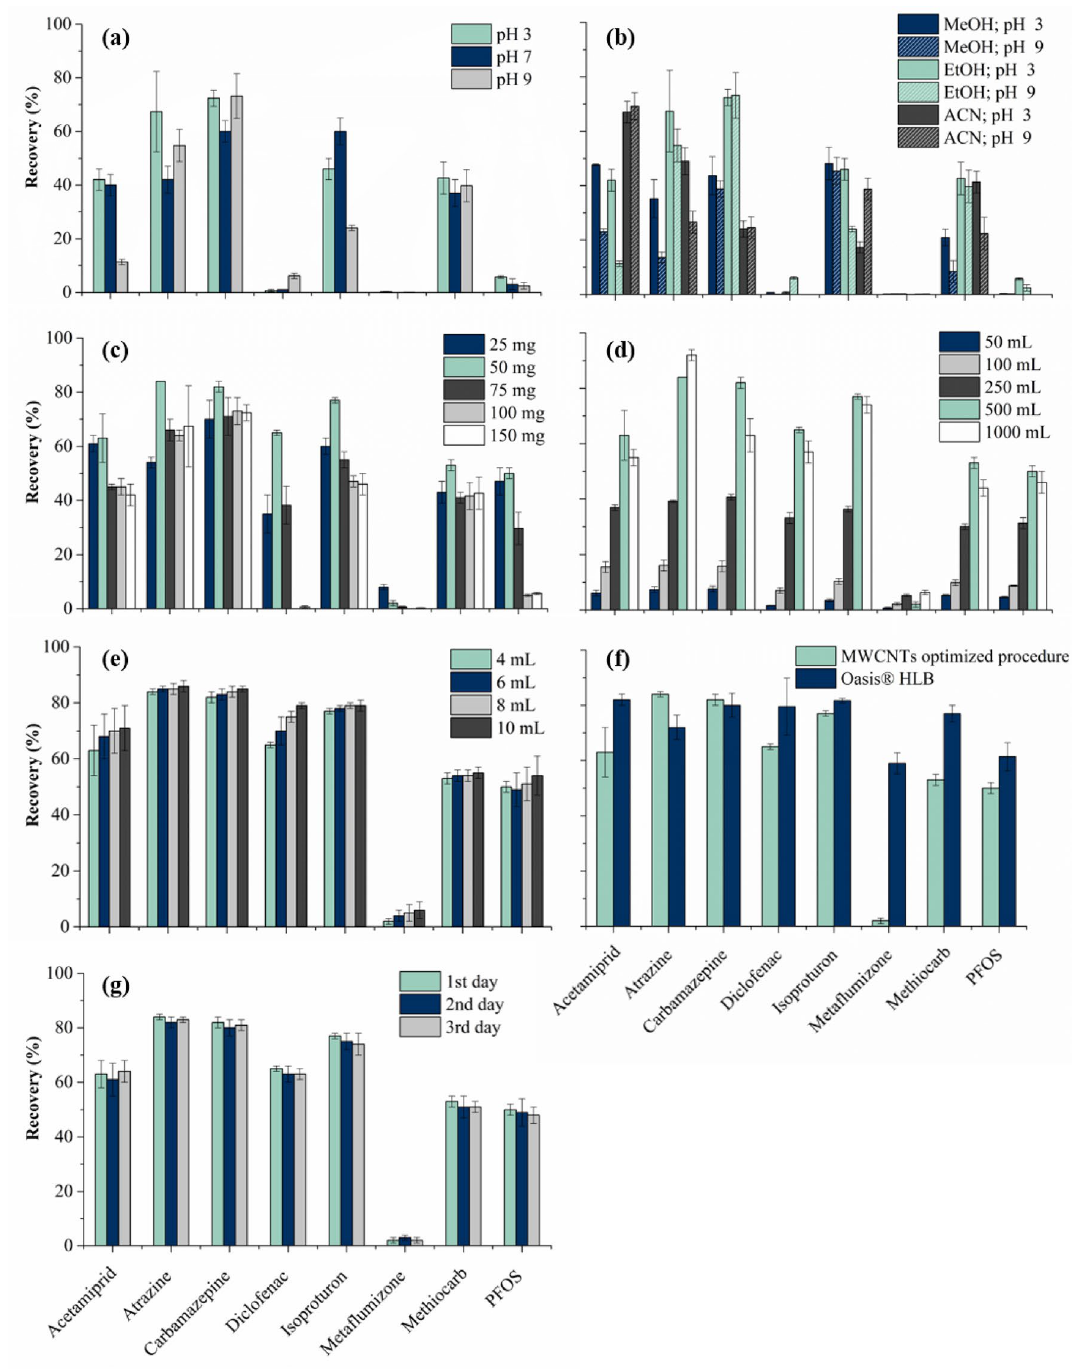
Figure 1. Recoveries obtained for micropollutants (200 ng L −1 each), using: ( a ) different pH (3, 7 and 9) (fixed conditions: cartridges packed with 150 mg of MWCNTs, 500 mL of SW and 4 mL of ethanol as a solvent); ( b ) different solvents (4 mL of methanol, ethanol or acetonitrile) and pH (3 and 9) (fixed conditions: cartridges packed with 150 mg of MWCNTs, 500 mL of SW and 4 mL of solvent); ( c ) cartridges packed with different amounts of MWCNTs (25–150 mg) (fixed conditions: pH 3, 500 mL of SW and 4 mL of ethanol as a solvent); ( d ) different volumes (50–1000 mL) of SW (fixed conditions: cartridges packed with 50 mg of MWCNTs, pH 3 and 4 mL of ethanol as a solvent); ( e ) using different volumes (4–10 mL) of ethanol as elution solvent (fixed conditions: cartridges packed with 50 mg of MWCNTs, 500 mL of SW, pH 3); ( f ) MWCNT optimized cartridge (50 mg) and commercial cartridge Oasis HLB (experiments performed with 500 mL of SW samples (pH 3) and using ethanol as solvent (4 mL); and ( g ) recoveries obtained for micropollutants (200 ng L –1 each), extracting 500 mL of SW (pH 3) with 4 mL of ethanol as solvent, during consecutive reuse cycles performed with the same cartridge packed with MWCNTs (50 mg); n = 3 (RSD is represented as error